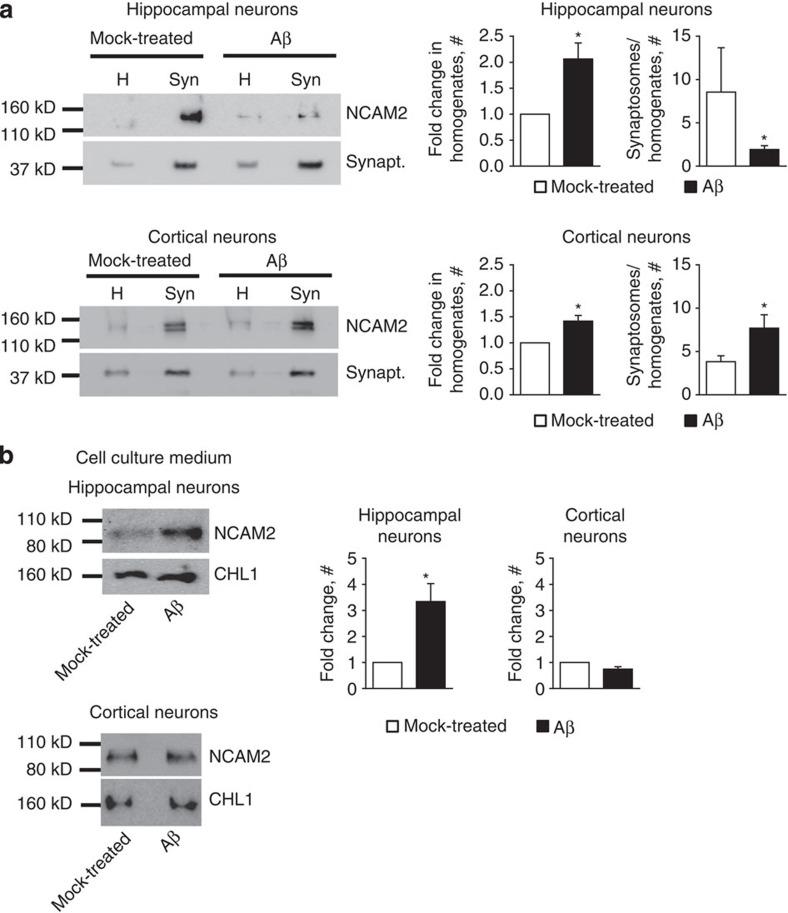
Levels of NCAM2 are reduced in synaptosomes of cultured hippocampal neurons treated with Aβ1-42 oligomers.(a) Western blot analysis of homogenates and synaptosomes isolated from cultured hippocampal or cortical neurons either mock treated or incubated with Aβ1-42 oligomers for 24 h. Blots were probed with antibodies against NCAM2 and synaptophysin used as a loading control. Note that NCAM2 is enriched in synaptosomes versus homogenates in hippocampal neurons and this enrichment is reduced in hippocampal neurons treated with Aβ1-42. Levels of NCAM2 in synaptosomes from cortical neurons are not reduced in response to Aβ1-42. NCAM2 levels are increased in homogenates of neurons treated with Aβ1-42 versus mock-treated neurons. Graphs show mean+s.e.m. fold change in NCAM2 levels in cell culture homogenates with levels in mock-treated neurons set to 1 (left panels), and mean+s.e.m. of the synaptic enrichment of NCAM2 defined as a ratio of NCAM2 levels in synaptosomes to homogenates (right panels) from n=5 independent experiments. *P<0.05 paired t-test. (b) Western blot analysis of the cell culture media collected from the hippocampal and cortical neurons either mock-treated or incubated with Aβ1-42 oligomers for 24 h. Blots were probed with antibodies against the extracellular domain of NCAM2. Note that levels of the soluble ∼100 kDa extracellular fragments of NCAM2 are increased in the culture media from cultured hippocampal neurons treated with Aβ1-42. Graphs show quantification of the blots (mean+s.e.m., n=3 independent experiments for hippocampal neurons, n=6 independent experiments for cortical neurons) with levels in mock-treated cultures set to 1. *P<0.05 paired t-test. For a,b, full-length versions of the blots are shown in Supplementary Fig. 10.